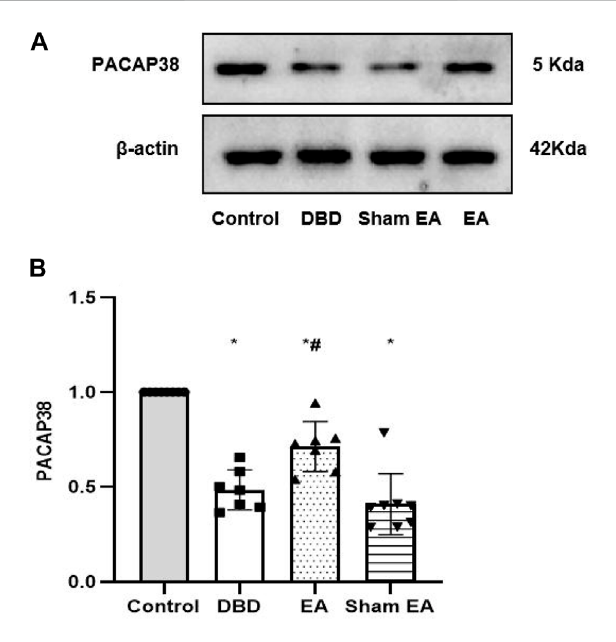
FIGURE 9 Expression of bladder PACAP38 protein in rats after the 8-week intervention (A) . Western blot bands of PACAP38 protein expression. (B) . Bar graphs show the quantitative analysis for PACAP38 protein expression. Control: n = 8 rats, DBD: n = 7 rats, EA: n = 7 rats, Sham EA: n = 8 rats. Results are expressed as mean ± standard error of